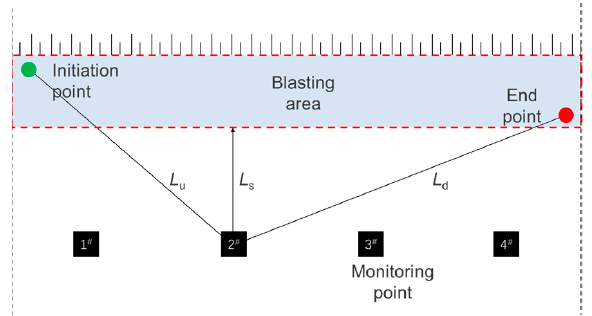
Figure 6. Schematic diagram of monitoring point layout.